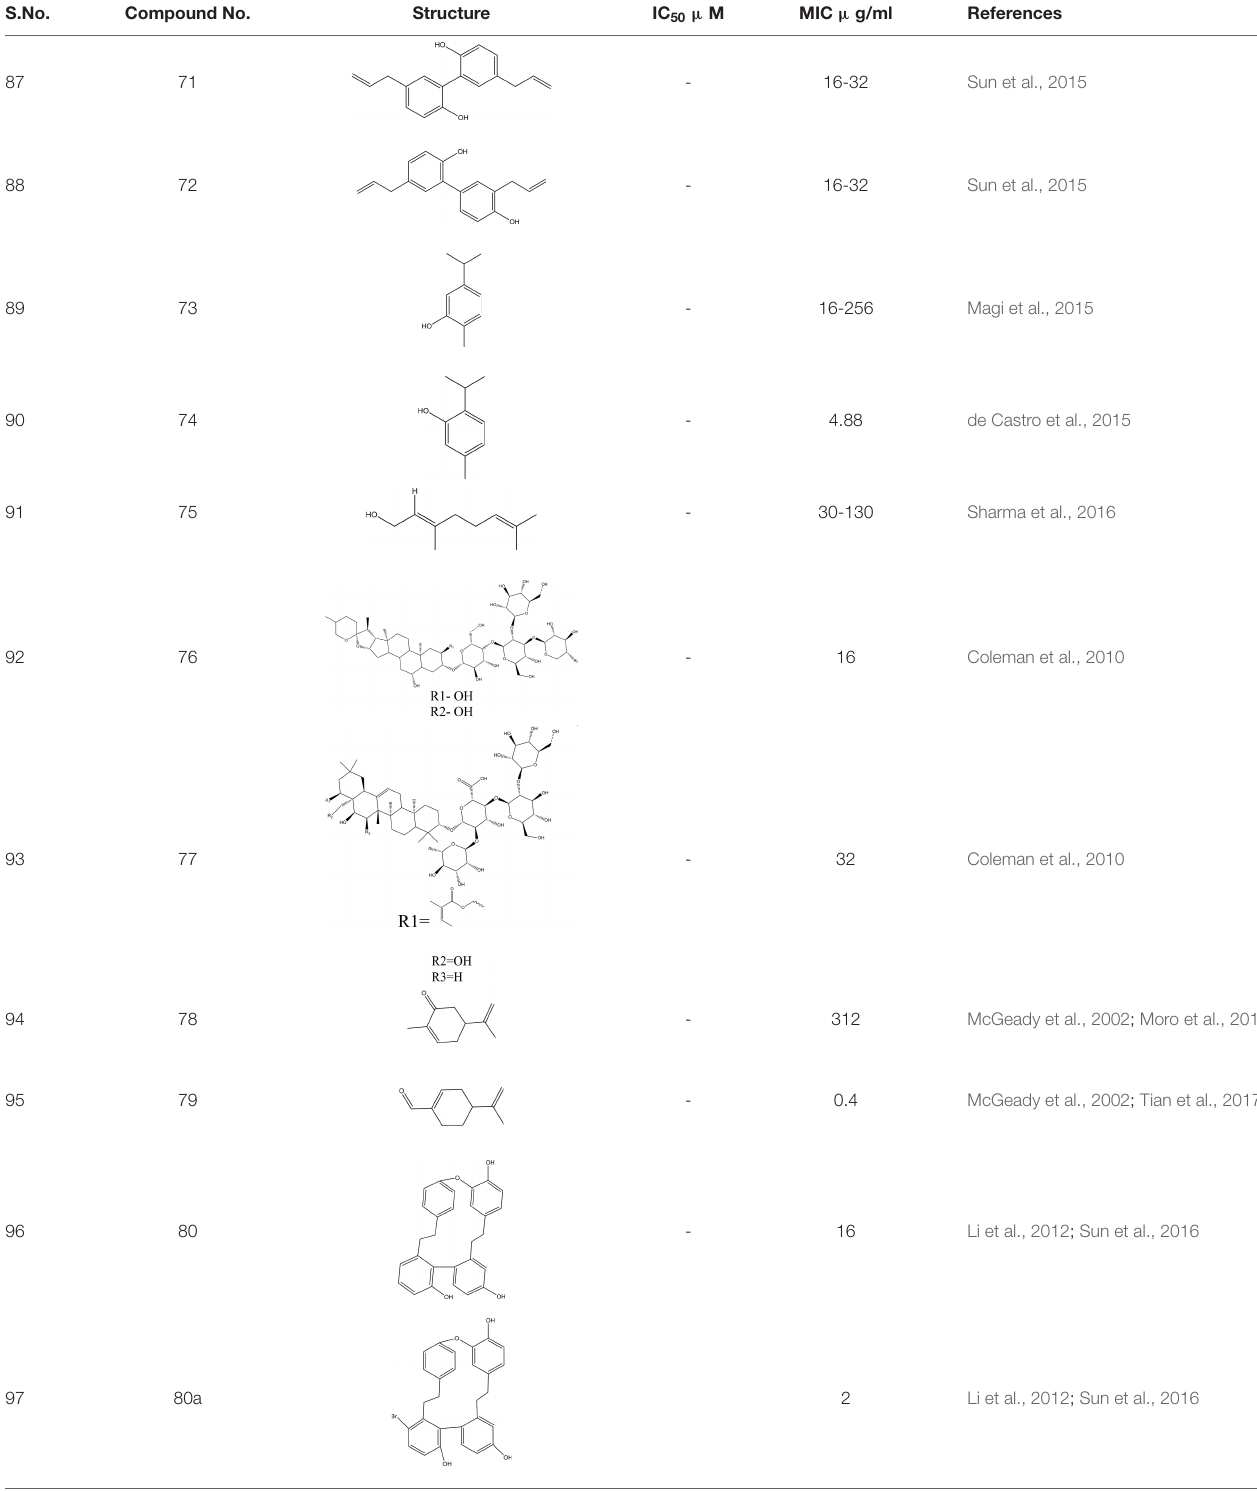
TABLE 5 | Chemical structures and MIC/IC 50 values of small molecule inhibitors (71–84). S.No. Compound